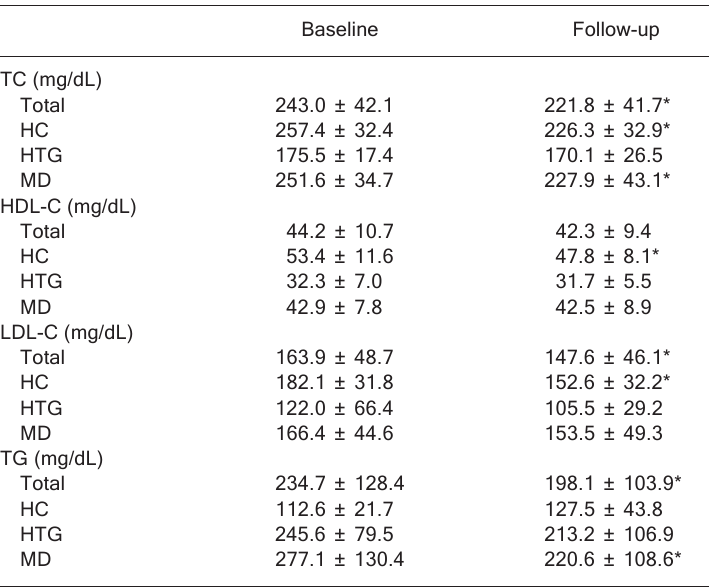
Table 2. Changes in lipid and lipoprotein concentrations after a 6- to 8-week low- fat dietary intervention as a function of type of